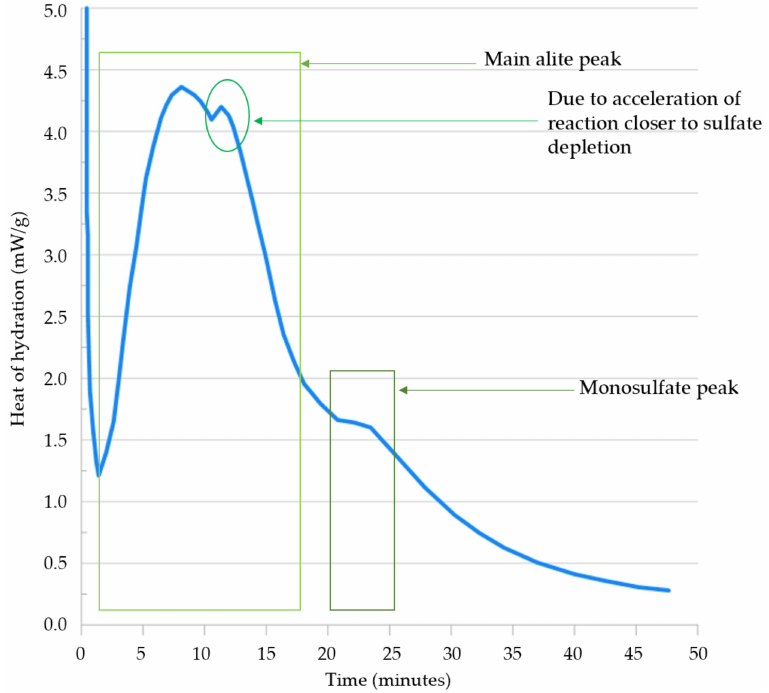
Figure 7. Rate of hydration observed for Portland cement (modified from